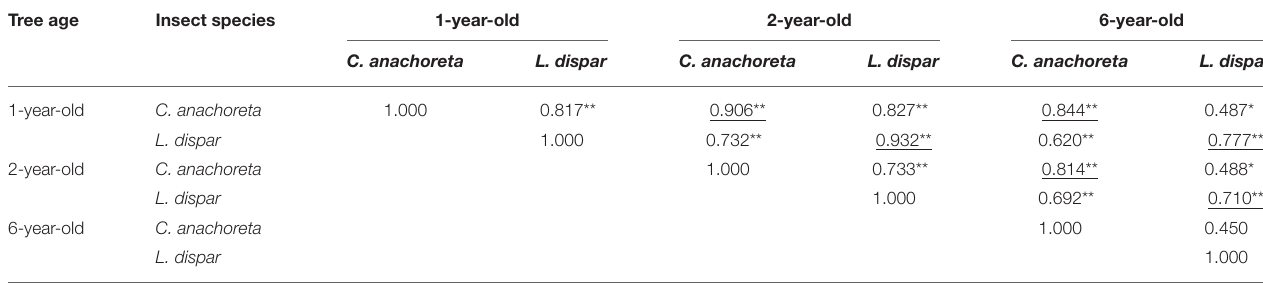
TABLE 2 | Correlation coefficients of different larval mortality rates of 19 transgenic lines among different years. Tree age Insect species